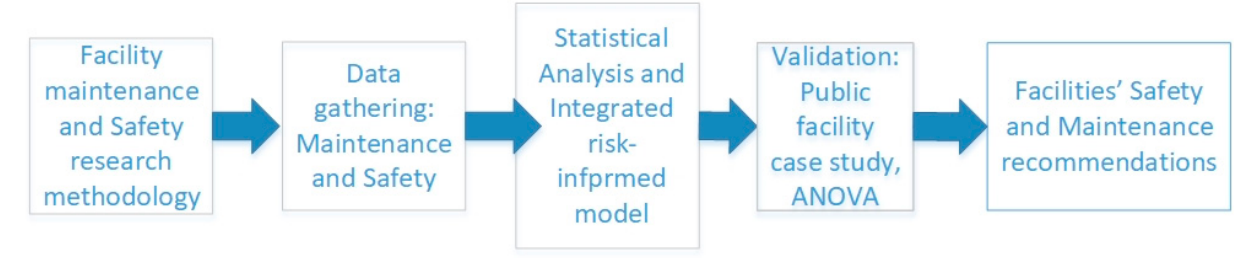
Figure 3. Research phases and methodology.